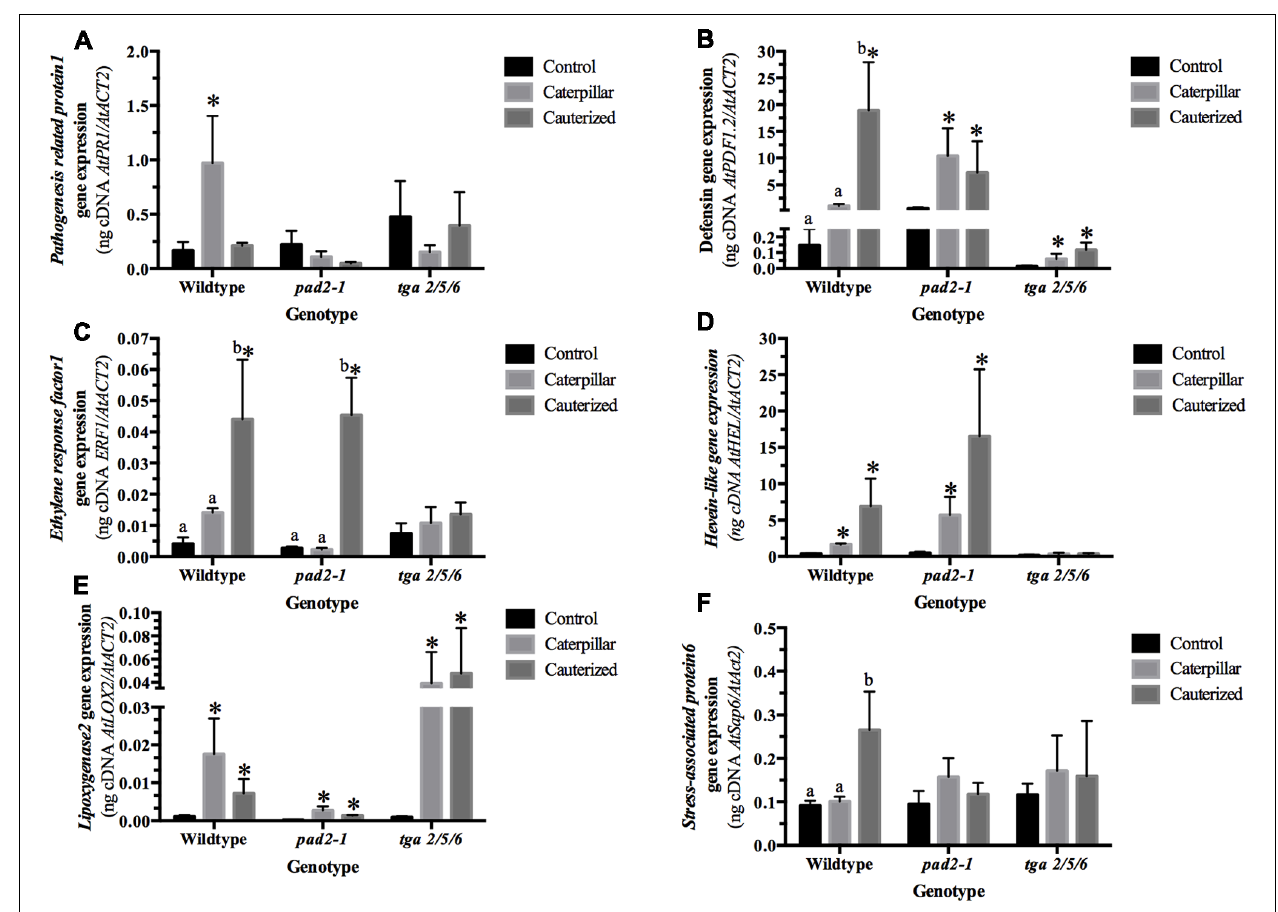
AtHEL , (E) AtLOX2 , (F) AtSAP6 . Bars represent the mean values of three to four independent replicates normalized with the reference gene AtACT2 ± SE.Within each genotype, lower case alphabetical letters indicate significant differences identified by ANOVA followed by aTukey HSD (p ≤ 0.05; n = 3–4; TableA2 in Appendix). An asterisk denotes a fivefold or higher change in expression from control